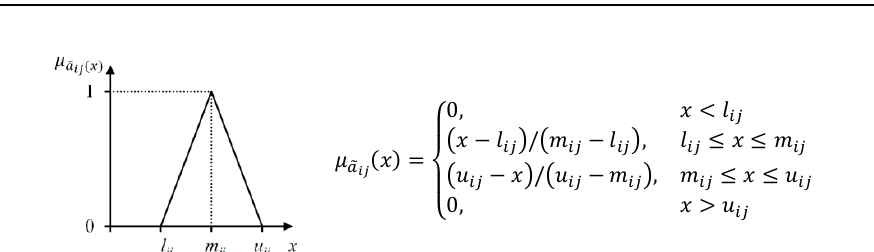
Figure 4. Spaces for linguistic variables illustrating the significance/influence of a system element, based on [29]. The advantage of using triangular fuzzy numbers is the simple implementation of arithmetical operations used in the proposed method. Arithmetical operations on any two triangular fuzzy numbers 𝑎̃ 11 = (𝑙 11 , 𝑚 11 , 𝑢 11 ) and 𝑎̃ 12 = (𝑙 12 , 𝑚 12 , 𝑢 12 ) are thus as follows [29]: 𝑎̃ 11 ⊕ 𝑎̃ 12 = (𝑙 11 + 𝑙 12 ,𝑚 11 + 𝑚 12 , 𝑢 11 + 𝑢 12 )